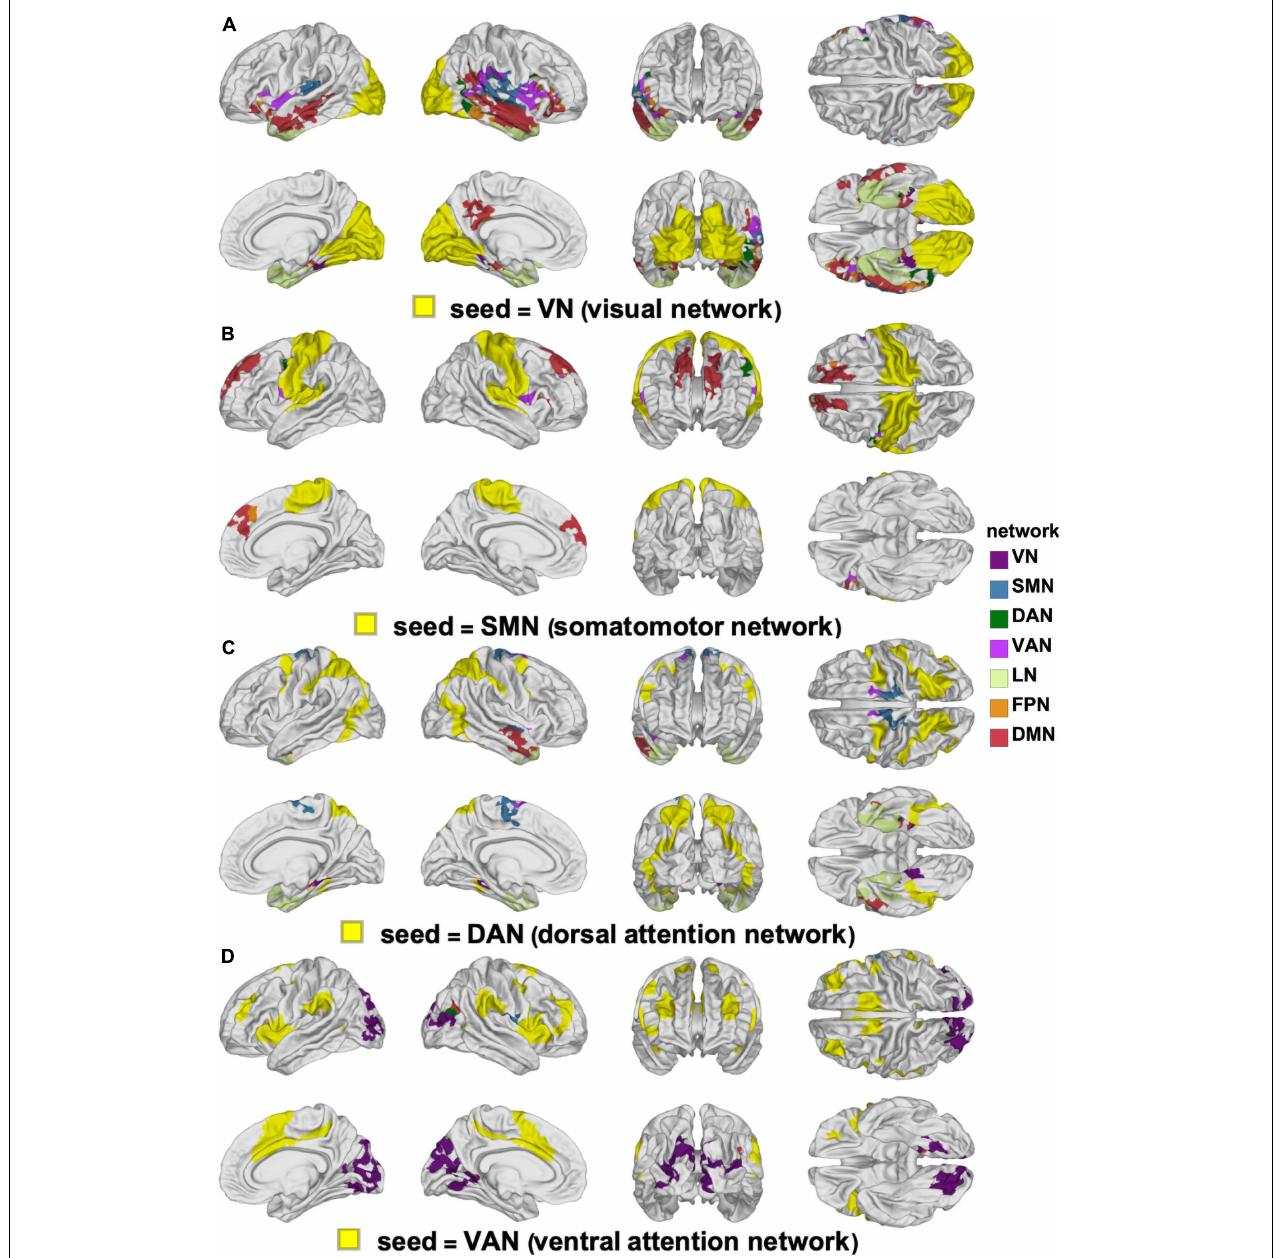
FIGURE 6 | Canonical RSNs (seeds, yellow) and corresponding cortical clusters whose FC with the corresponding seed network changes significantly according to sex. The seed RSNs are the VN (A) , SMN (B) , DAN (C) , and VAN (D) . DAN, dorsal attention network; FC, functional correlation; RSN, resting state network; SMN, somatomotor network; VAN, ventral attention network; VN, visual